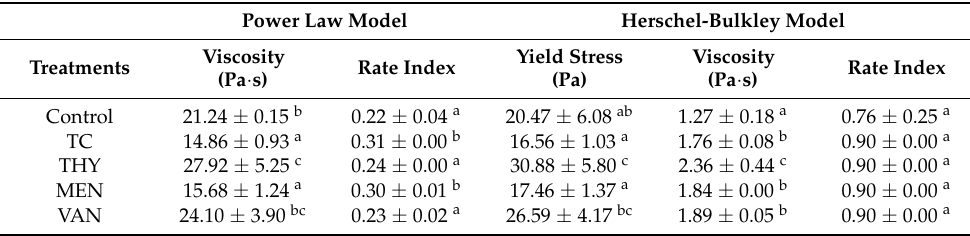
Table 1. Rheological results of TC, THY, MEN or VAN egg yolk ice creams in mixtures and after ice-cream